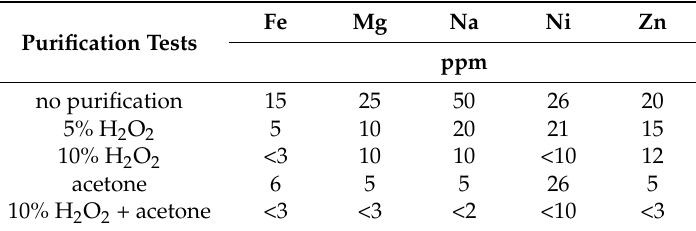
Table 12. Impurity contents in crystallized RbReO 4 after